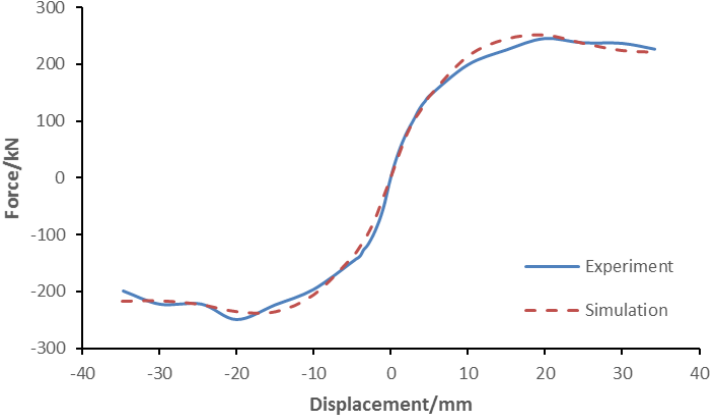
Figure15. Hysteretic curves. Figure 15. Hysteretic